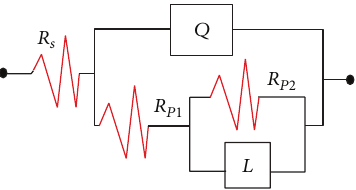
Figure4:TheequivalentcircuitusedtofittheexperimentalEISdata obtained for the HSLA steel after its immersion for different periods of time in 2.0 M sulfuric acid